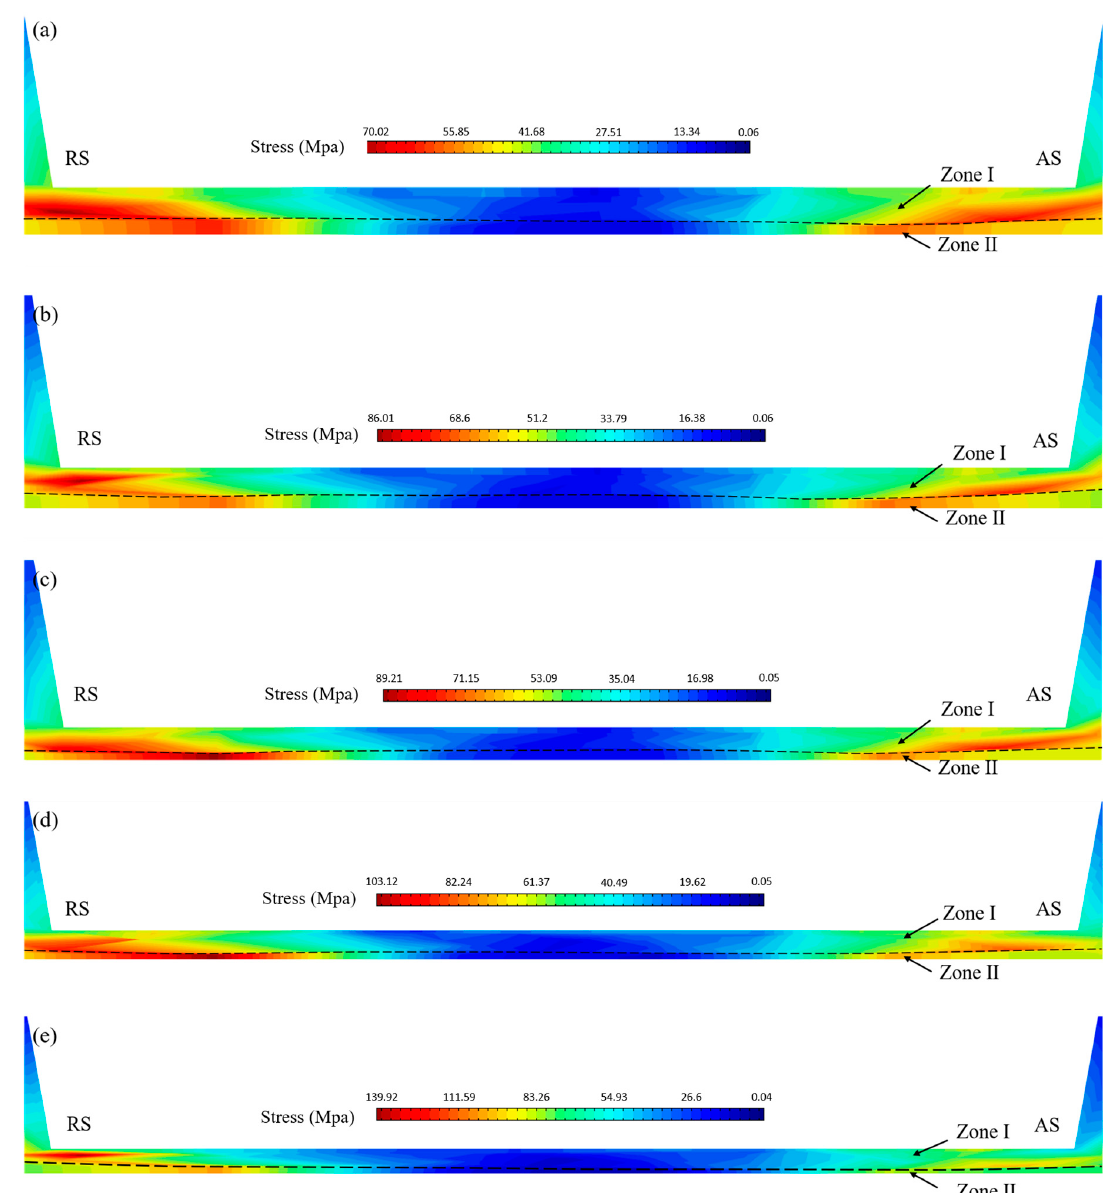
Figure 16. Distribution of shear stress at the root of the joint at different pin lengths (1000 rpm, 120 mm / min). ( a ) 5.91 mm; ( b ) 5.92 mm; ( c ) 5.93 mm; ( d ) 5.94 mm; ( e ) 5.95 mm.